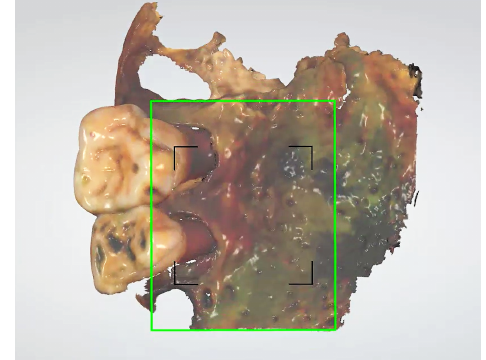
Figure 2. Intraoral camera scanning Neolithic maxilla fragment with two deciduous teeth